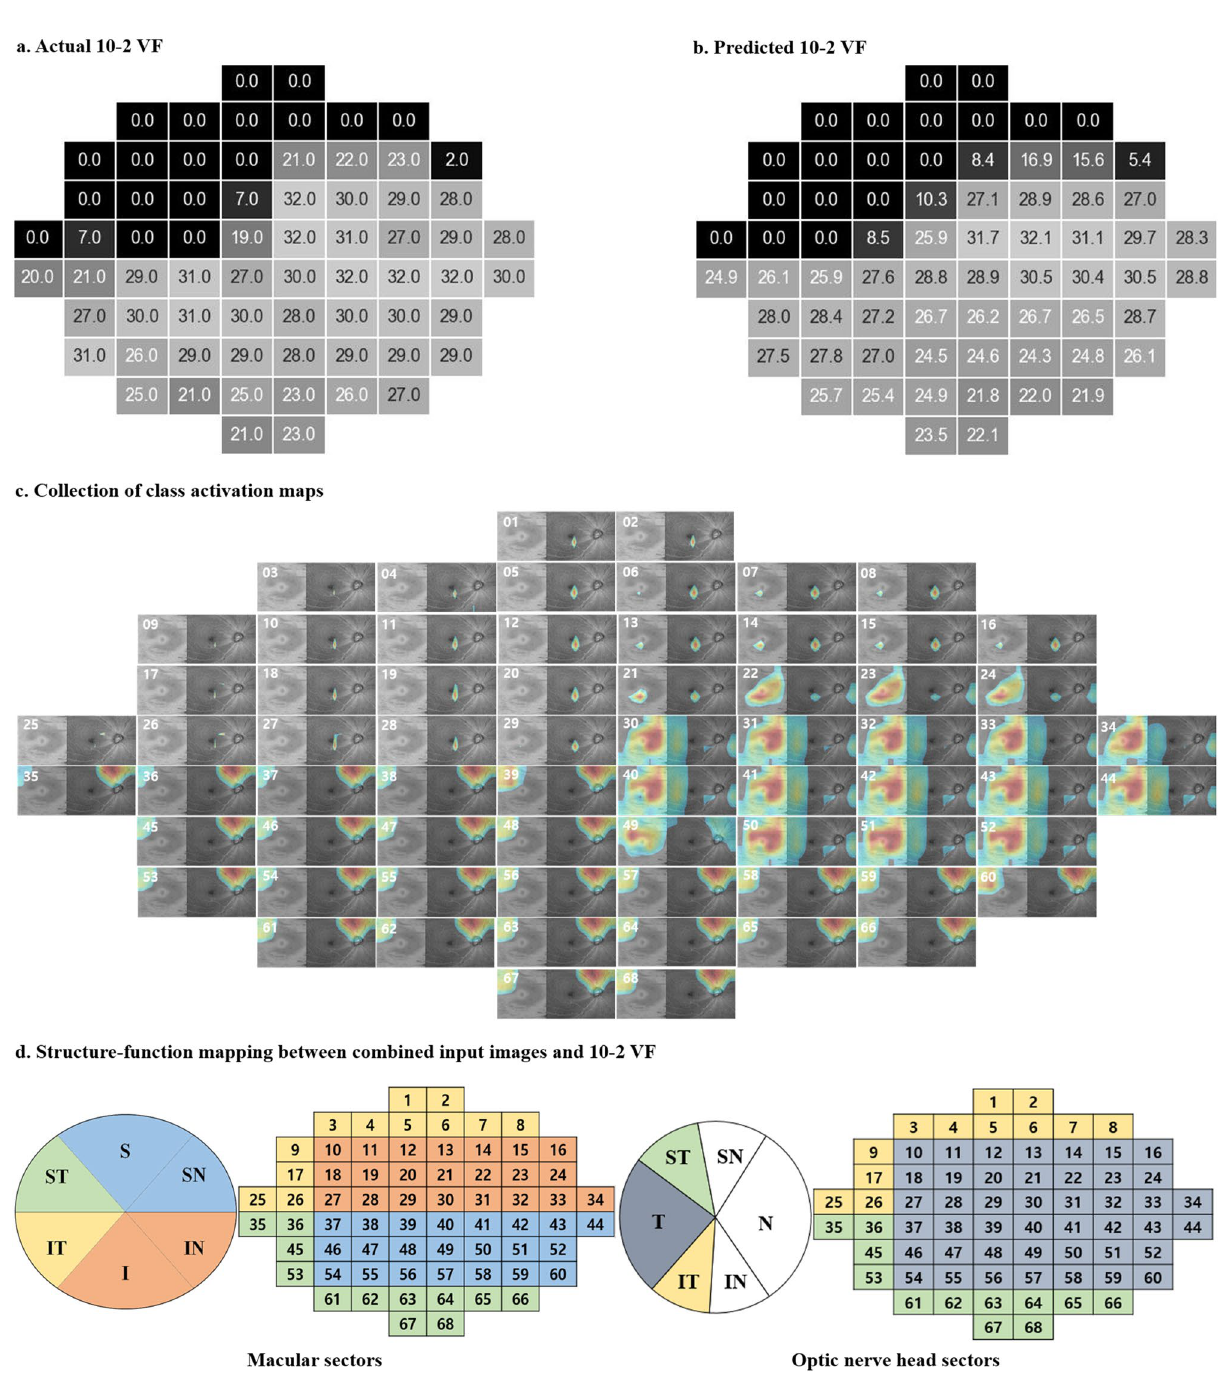
Figure 5. Representative example of Class Activation Mapping (CAM) with the en face model. Sixty-eight class activation maps were placed at the individual 10-2 visual field (VF) test points (right eye). The figure shows the actual 10-2 VF threshold values (THVs) and the predicted THVs ( a , b ). Each CAM image is numbered at the top left ( c ). The red color indicates the region where the deep learning model was highly activated and generated a high sensitivity value for the 10-2 VF test point, whereas the blue color indicates the opposite ( c ). Structure– function mapping between combined input images (including macula and optic nerve head scan; each in the left column) and 10-2 VF (right column) ( d ). The macula and optic nerve head sectors and the corresponding 10-2 VF regions are indicated with similar color 27 . The numbers in the VF images are the same as those in the CAM